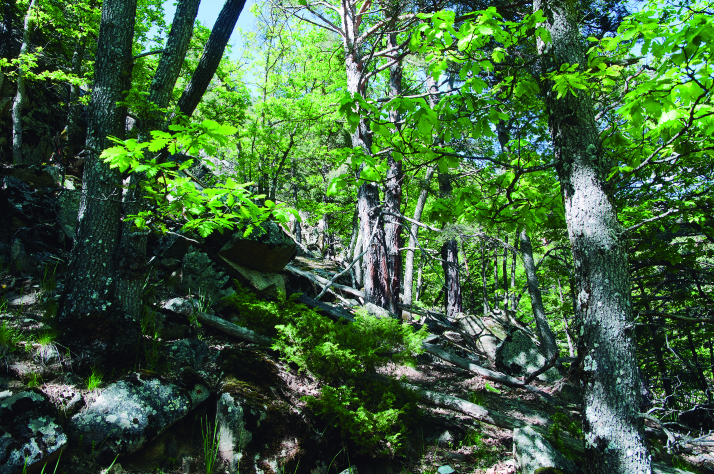
A2 plot Sola de Boi, Q.
pubescens forest